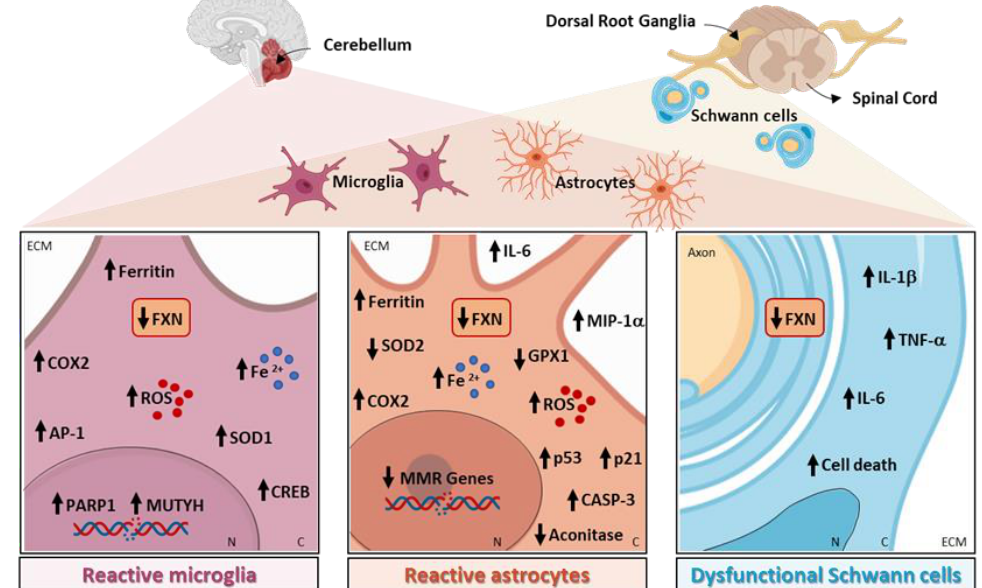
Figure 1. Neuroinflammation-related pathways altered in Friedreich’s ataxia (FRDA). Cerebellum, spinal cord, and dorsal root ganglia are three of the principal nervous system organs involved in the pathogenesis of FRDA. The genetically decreased expression of frataxin (FXN) leads to the disturbance of the metabolism of iron with the consequent iron increase in reactive microglia and astrocytes, together with mitochondria dysfunctions. FRDA microglia show an increase in oxidative damage, and the DNA repair proteins MUTYH and PARP-1, reactive oxygen species (ROS), activator protein 1 (AP1), and cAMP response element-binding protein (CREB), known to drive cyclooxygenase 2 (COX2) expression. In FRDA astrocytes, the depletion of FXN leads to an increase in ROS, COX2, MIP-1 α , IL-6, p53, p21, and activated caspase-3 (CASP3), and to a decrease in mitochondrial